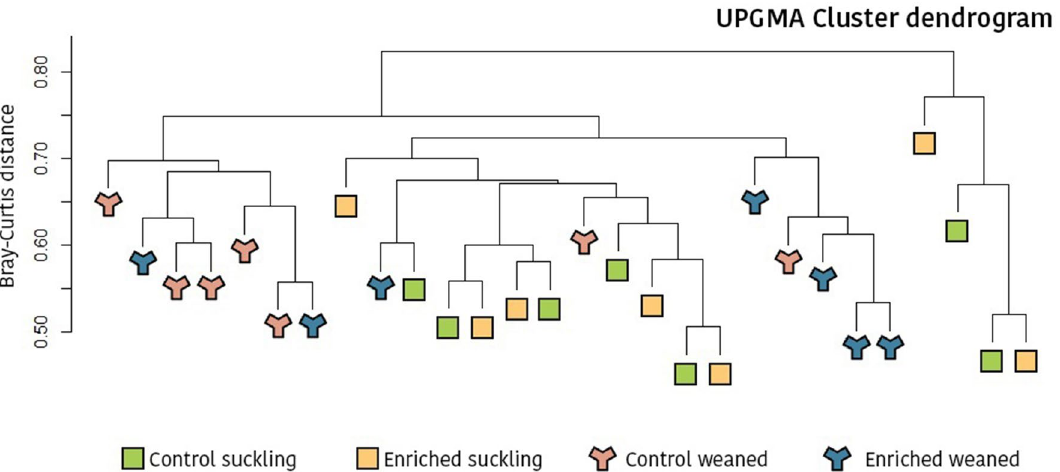
Figure 1. Hierarchical grouping dendrogram by UPGMA (average method) based on Bray–Curtis distances and relative OTU counts. A clear clustering is observed between suckling and weaned piglets. Likewise, enriched weaned piglets assimilate more to suckling animals than to the other control weaned piglets. Figure created by using open-source software R v3.5.3. (https ://www.r-proje ct.org/found ation